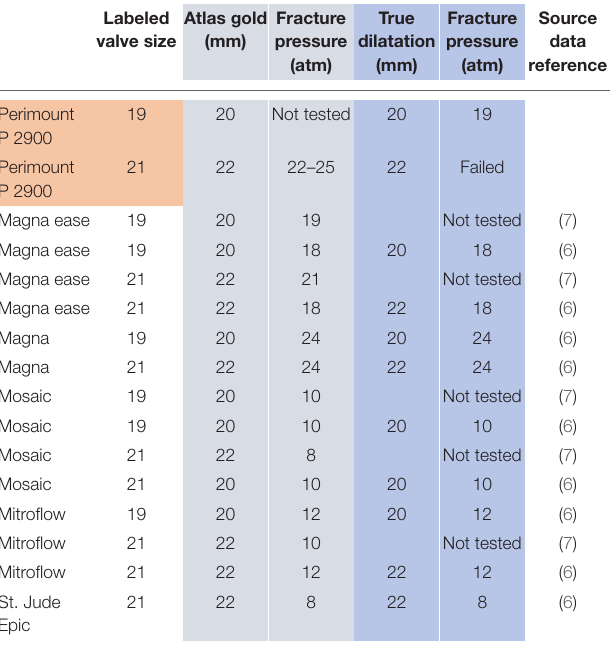
TABLE 1 | In vitro fracturing studies of PERIMOUNT model P2900 bioprosthetic valve. PM 19 - I